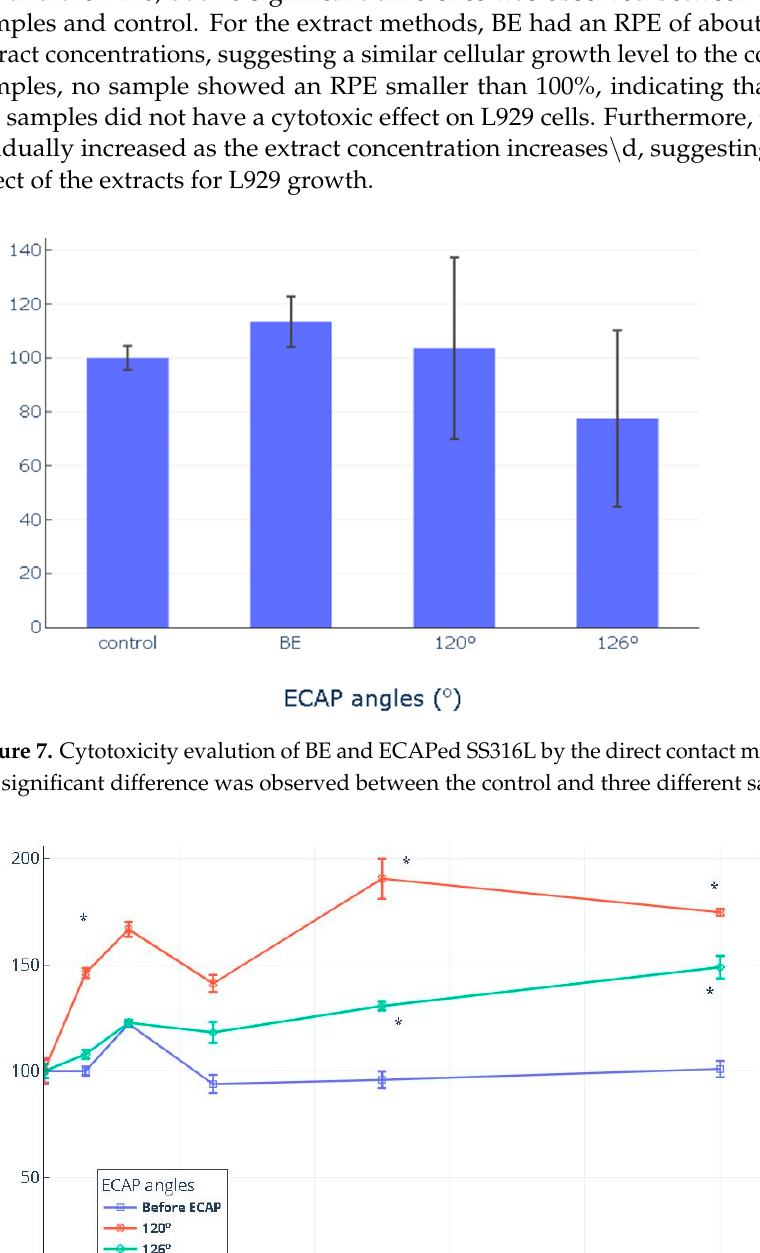
Figure 6. ( a ) Contact angle and ( b ) surface roughness properties of SS316L before and after ECAP.